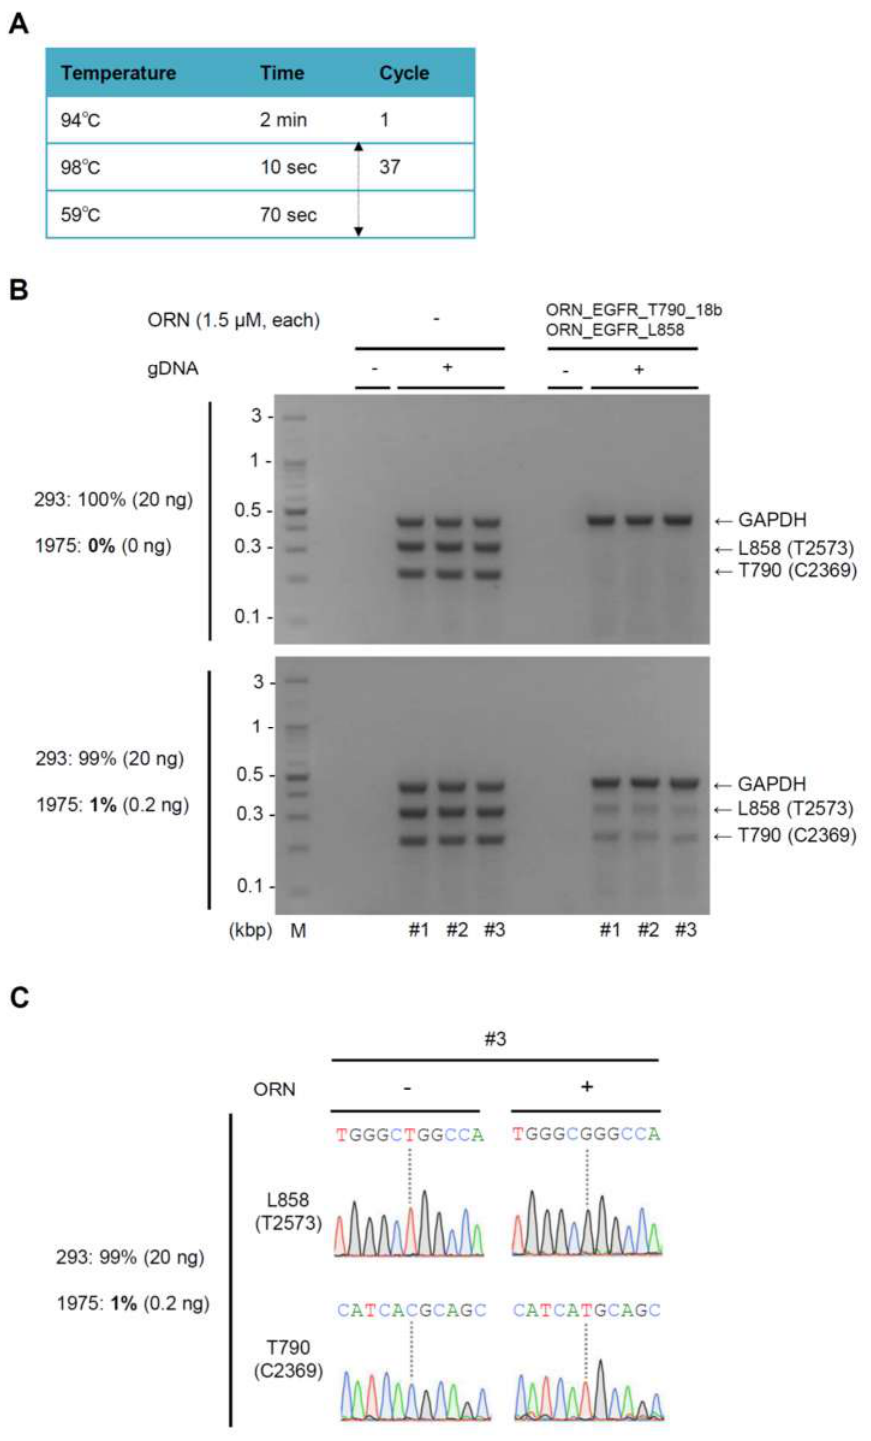
Figure 5. Sensitivity of multiplex ORNi-PCR for simultaneous detection of the T790M (C2369T) and L858R (T2573G) mutations in gDNA. ( A ) Conditions for multiplex ORNi-PCR with gDNA. ( B ) Results of ORNi-PCR with gDNA. Based on Figure 3E, 1.5 µ M each of ORN_EGFR_T790_18b and ORN_EGFR_L858 were used simultaneously. Either 293T gDNA (upper panel) or 293T gDNA mixed with NCI-H1975 gDNA (lower panel) was used for multiplex ORNi-PCR combined with an internal control PCR. Results of triplicate experiments are shown. ( C ) Results of DNA sequencing analysis. PCR or ORNi-PCR amplicons shown in ( B , lower panel) were subjected to DNA sequencing analysis. Sequencing signals from PCR (#3) and ORNi-PCR (#3) around T790 (C2369) and L858 (T2573) are shown.